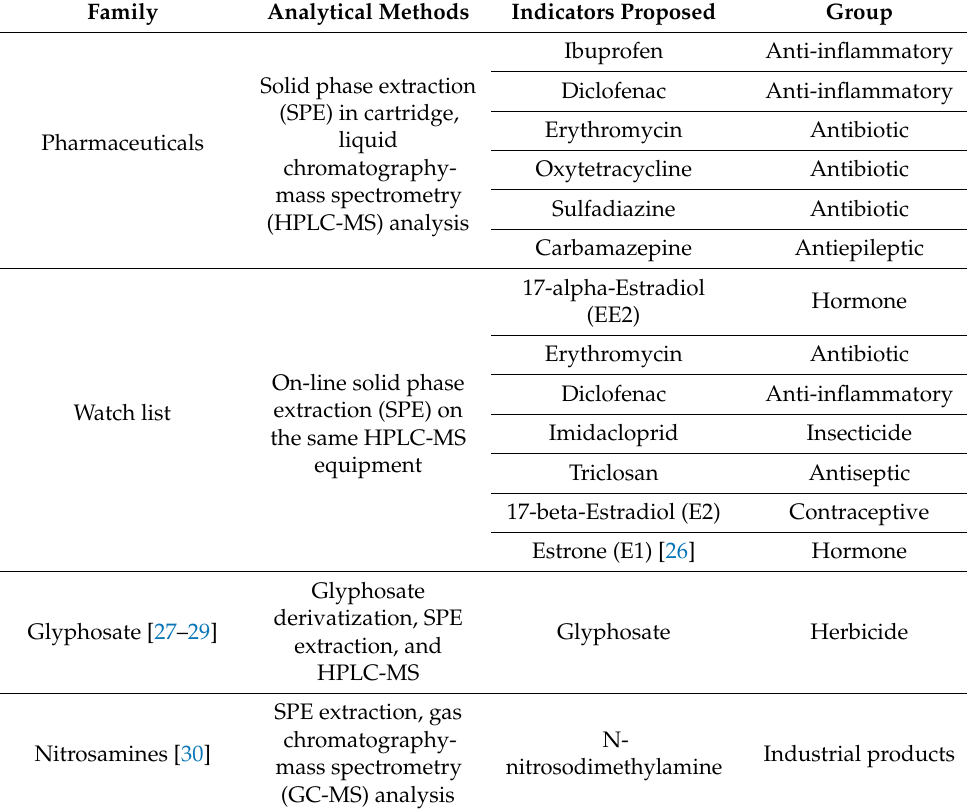
Table 1. Summary of compounds analyzed and analytical methods